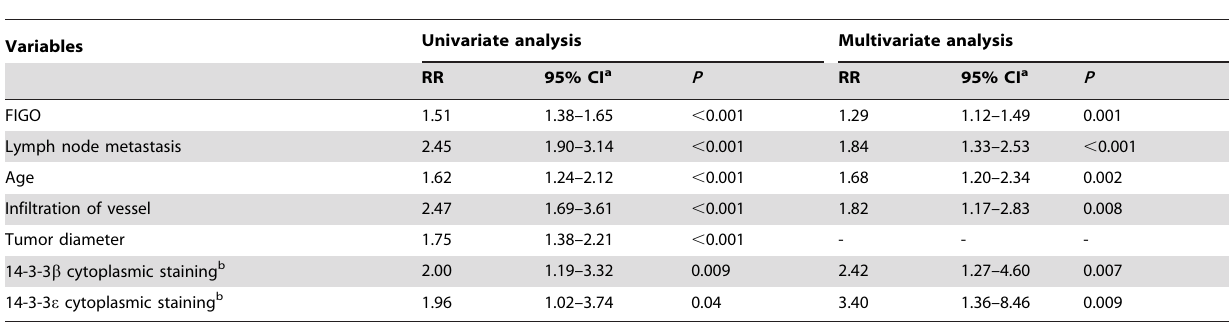
Table 1. Relative risk (RR) of dying from vulvar